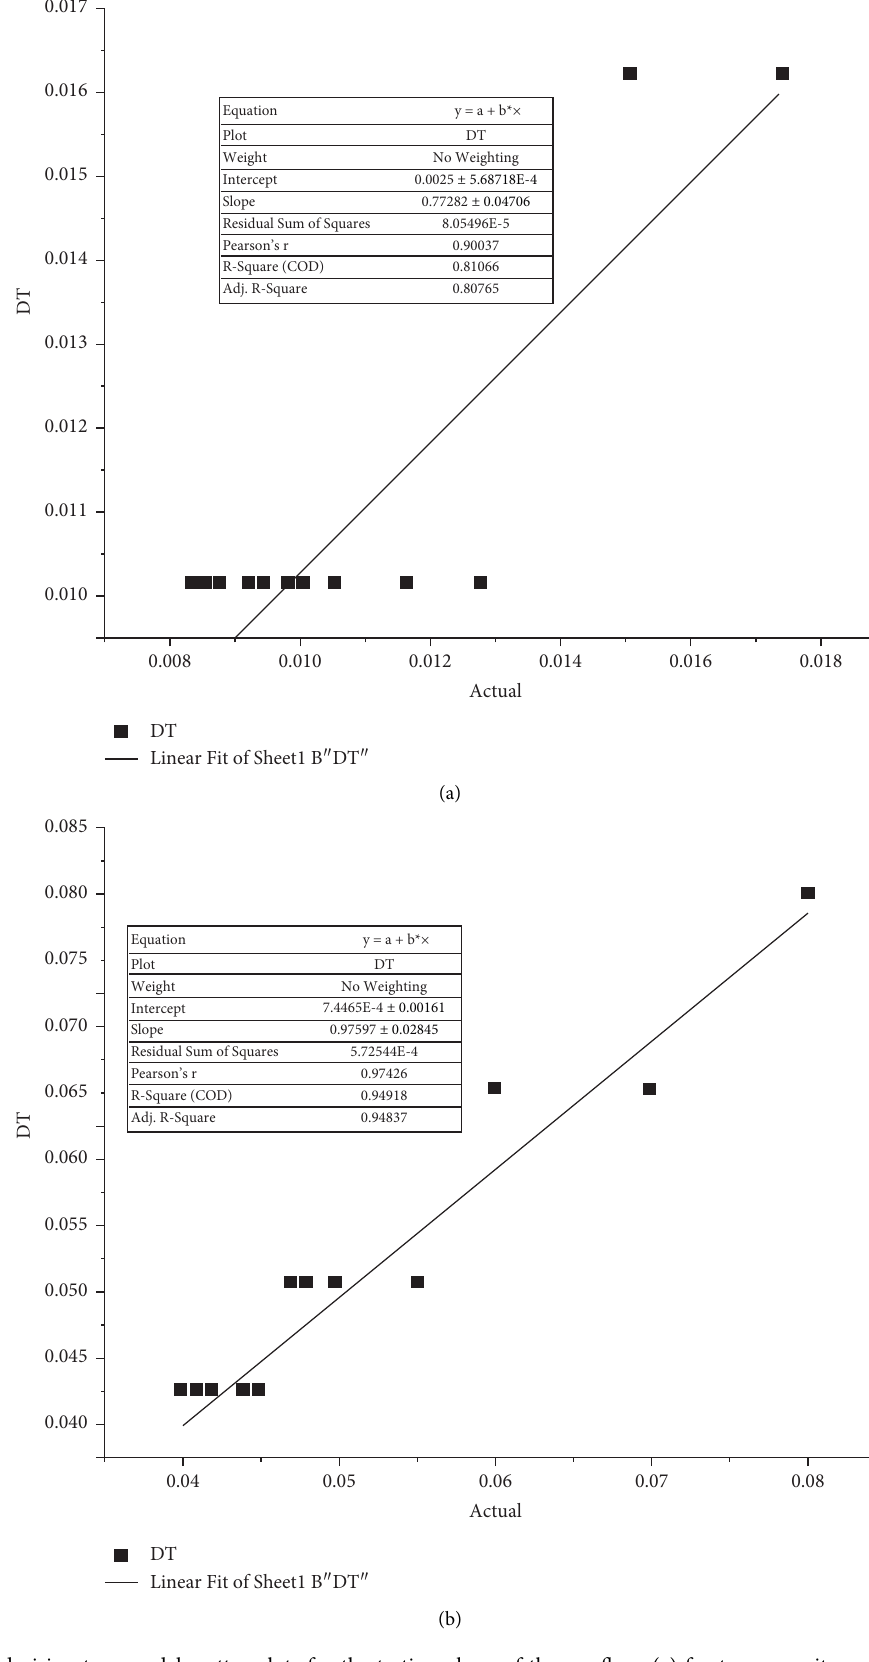
Figure 3: Te decision tree model scatter plots for the testing phase of the gas fow: (a) fracture porosity and (b) shape